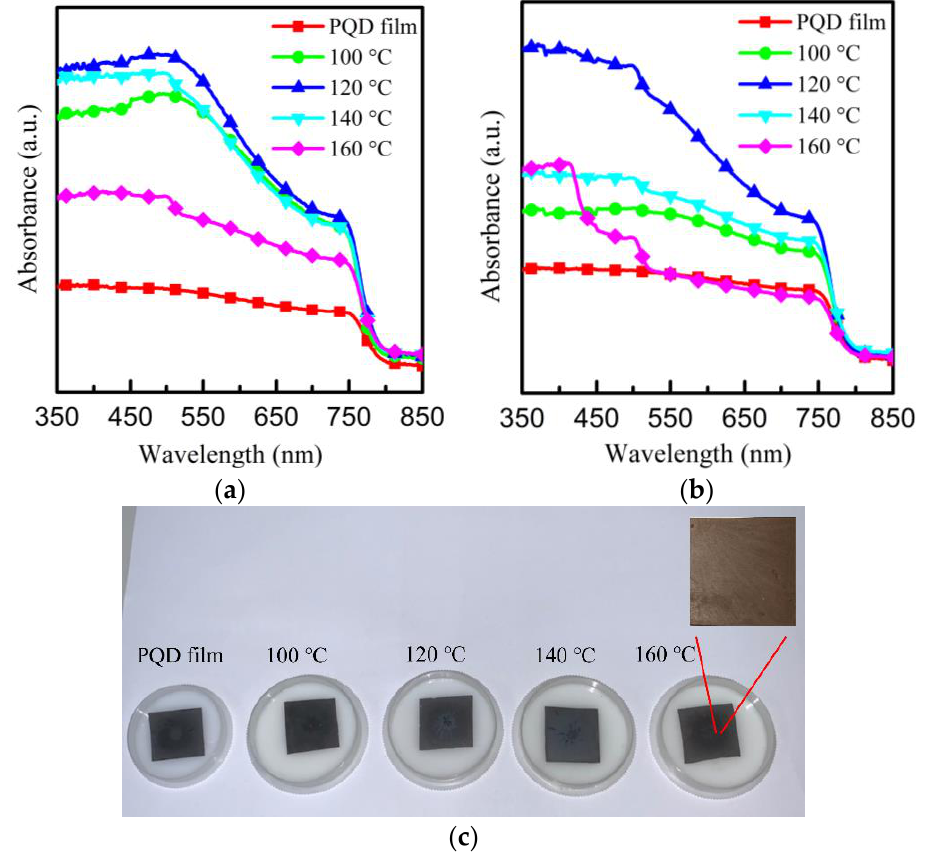
Figure 7. ( a ) UV-vis absorption spectra for pristine PQD films at different annealing temperatures. ( b ) All the above samples were stored in ambient air for 168 h. ( c ) Morphology of thin film for all samples at annealed temperature of 100 – 160 °C and zoom-in image (insert) at annealing temperature of 160 °C.